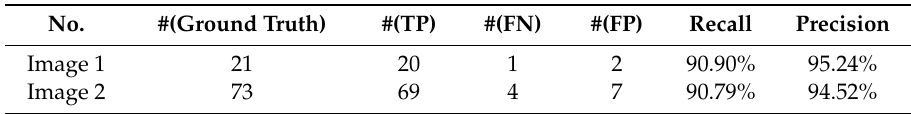
Table 6. The ship detection results of RadarSat-1 and Gaofen-3. TP: ships are correctly detected; FN: false alarm; FP: miss-detection.